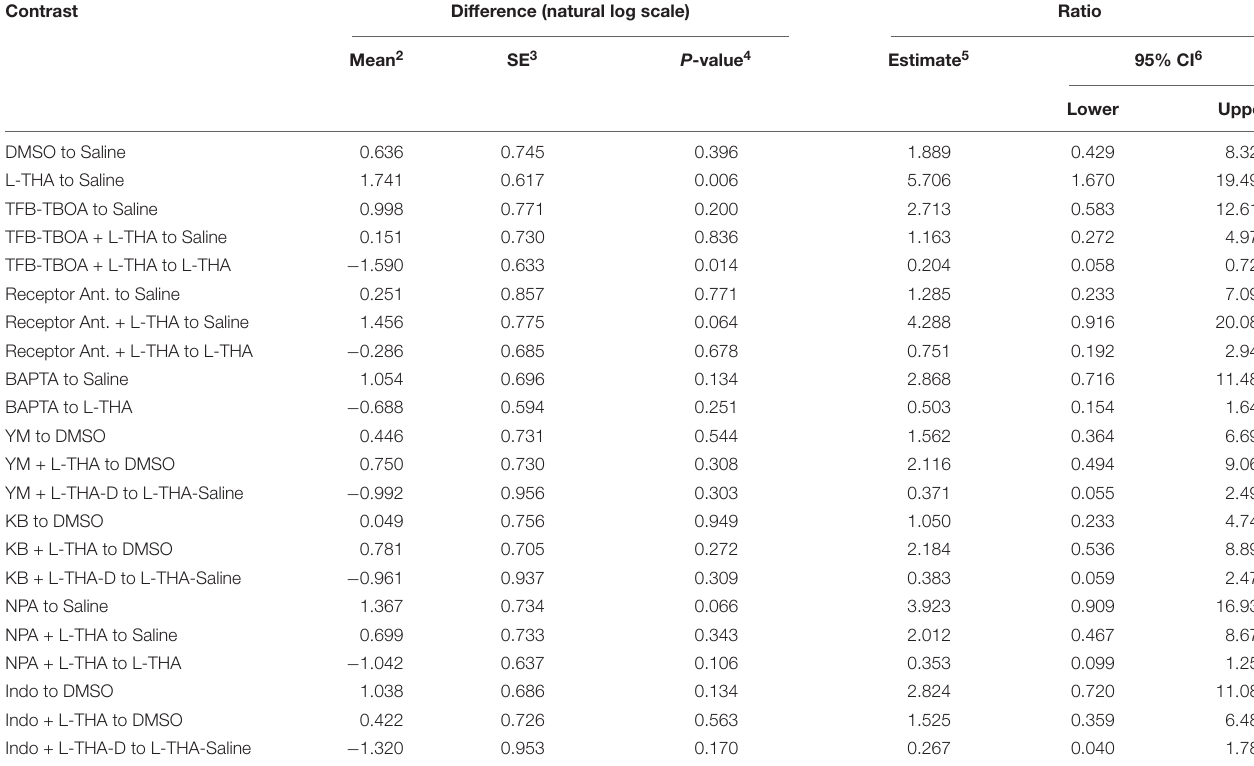
TABLE 1 | Combined pulses – Area under the curve 1